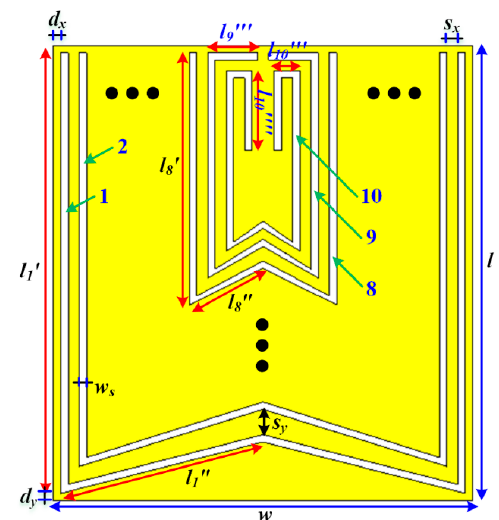
Figure 1. Geometry of the tag.